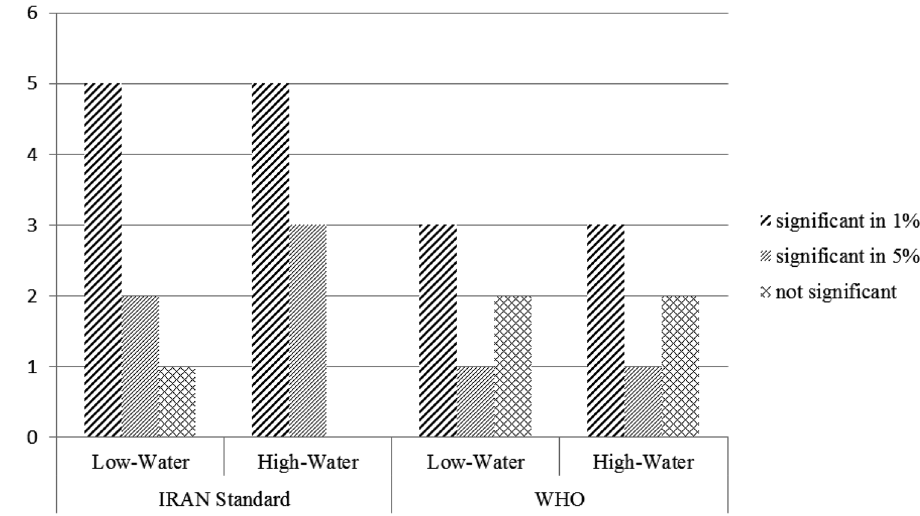
Fig. 3 The number of param- eters and quality changes based on national and international standards during different